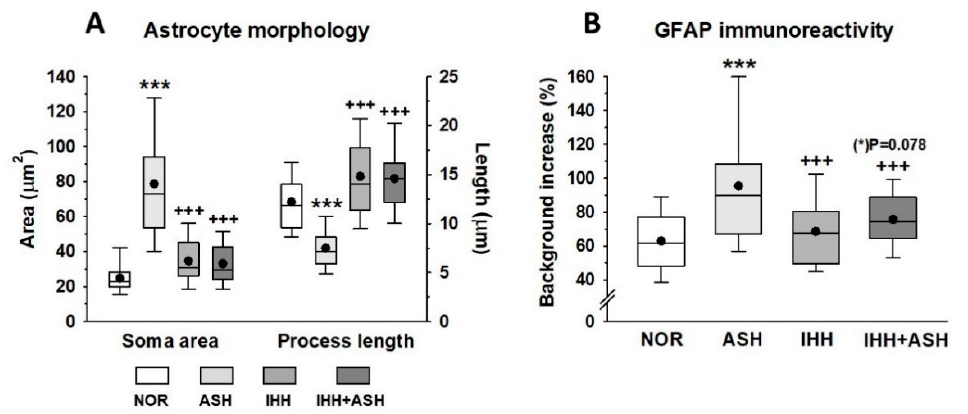
Figure 5. ( A ) Astrocyte morphometrical parameters (soma area and process length morphology). ( B ) expression of astrocyte glial fibrillary acidic protein (GFAP) immunoreactivity. All data were obtained in the Cornu ammonis (CA1) hippocampal zone. The box represents the interquartile range in the box-and-whisker plots and shows the first and third quartiles separated by the median. The black dot represents the mean, and whisker endpoints represent the minimum and maximum values. Statistically significant differences between groups are presented with asterisks (*, vs. NOR) or crosses (+, vs. ASH). The three symbols indicate p < 0.001. F-values after running one-way ANOVAs with Bonferroni’s post hoc multiple comparison tests were: F = 85.94 (soma area), F = 119.93 (process length) and F = 20.77 (GFAP immunoreactivity). Animal experimental groups are abbreviated as NOR, normoxic; ASH, acute severe hypoxia; IHH, intermittent hypobaric hypoxia; IHH+ASH, intermittent hypobaric hypoxia followed by acute severe